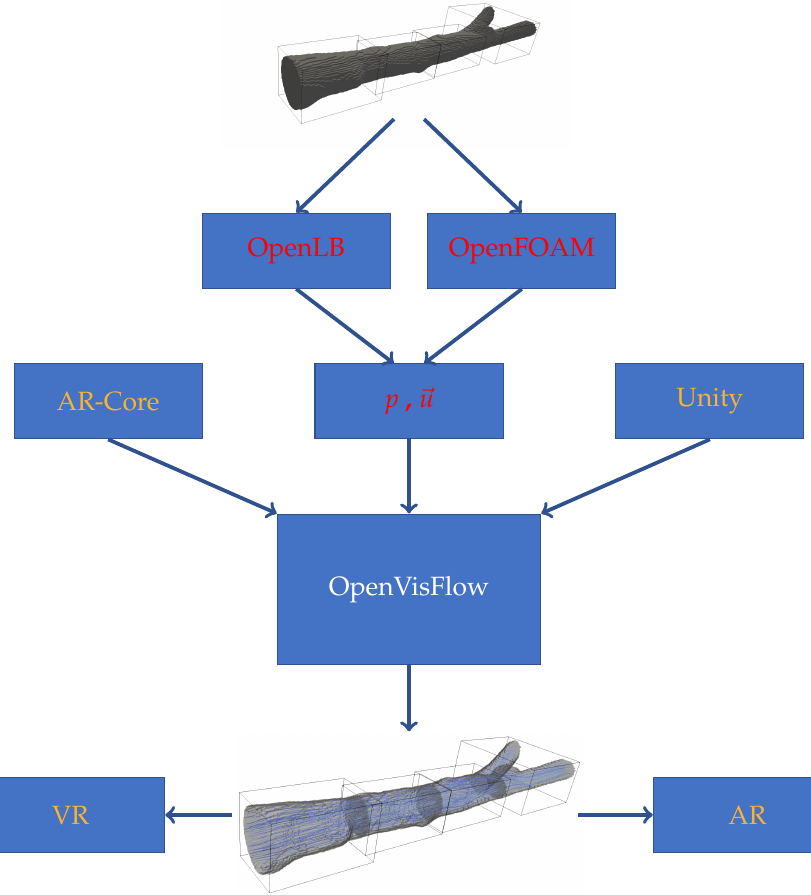
Figure 1. Concept of the OpenVisFlow library, bridging the gap between simulation software (red) and helping libraries (yellow) to directly write programs and apps that scientifically visualize the calculated flows in AR, VR, or on an ordinary screen. Some of the OpenVisFlows functions can be seen in the OpenLBar application.